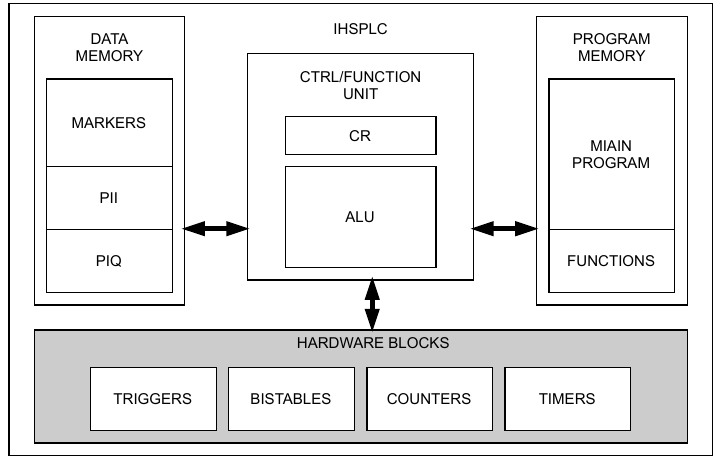
Figure 4. The idea of the Integrated Hardware-Software PLC.